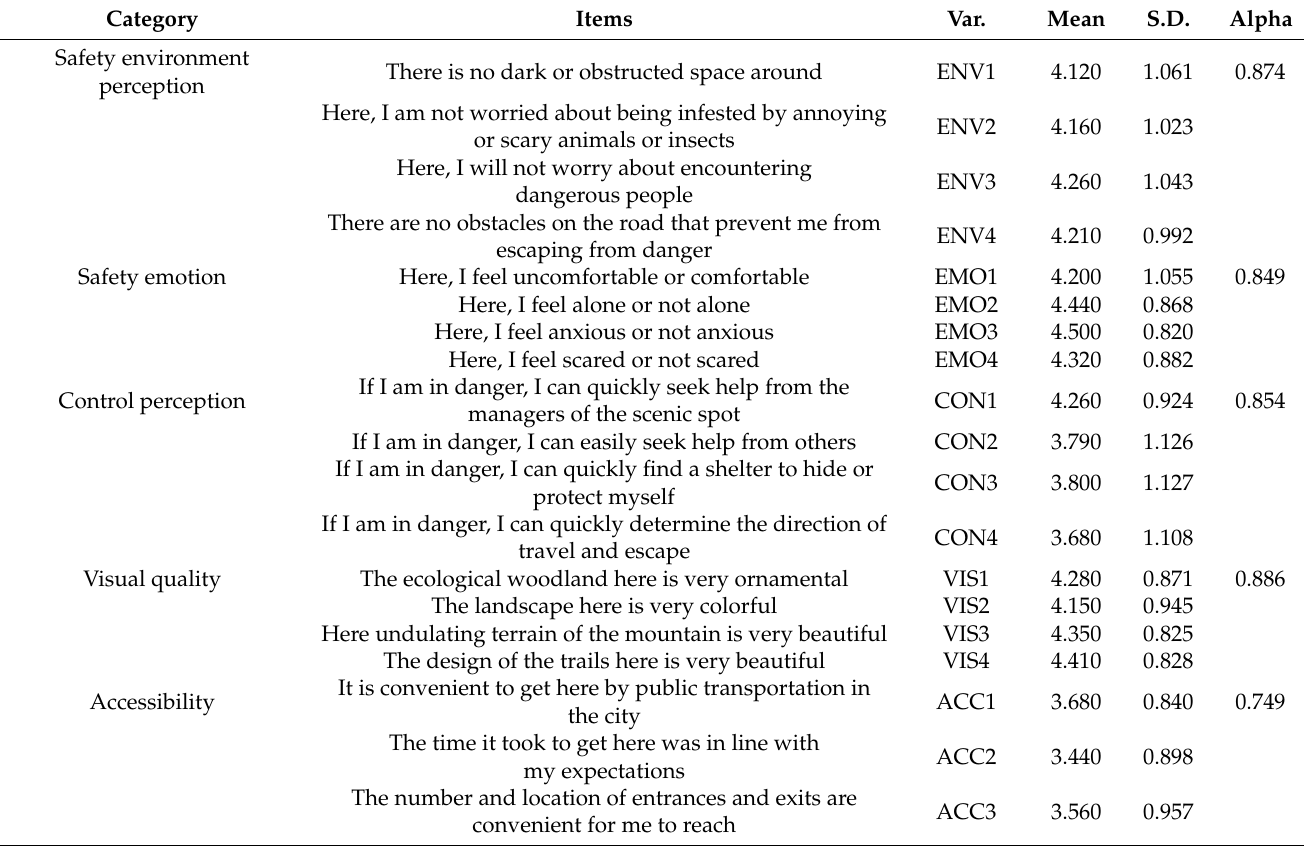
Table 3. Reliabilities of